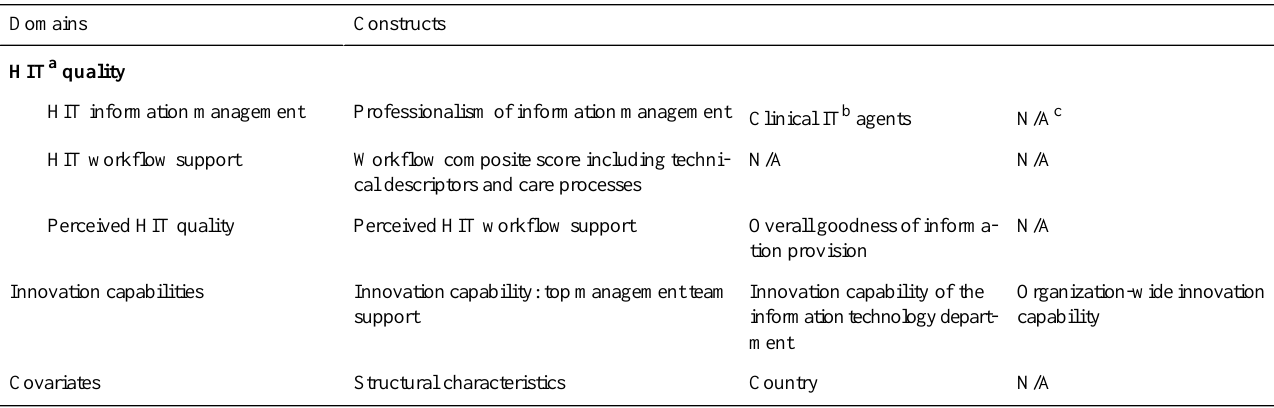
Table 1. Overview of the constructs used to operationalize the domains of the conceptual innovation and quality of health information technology